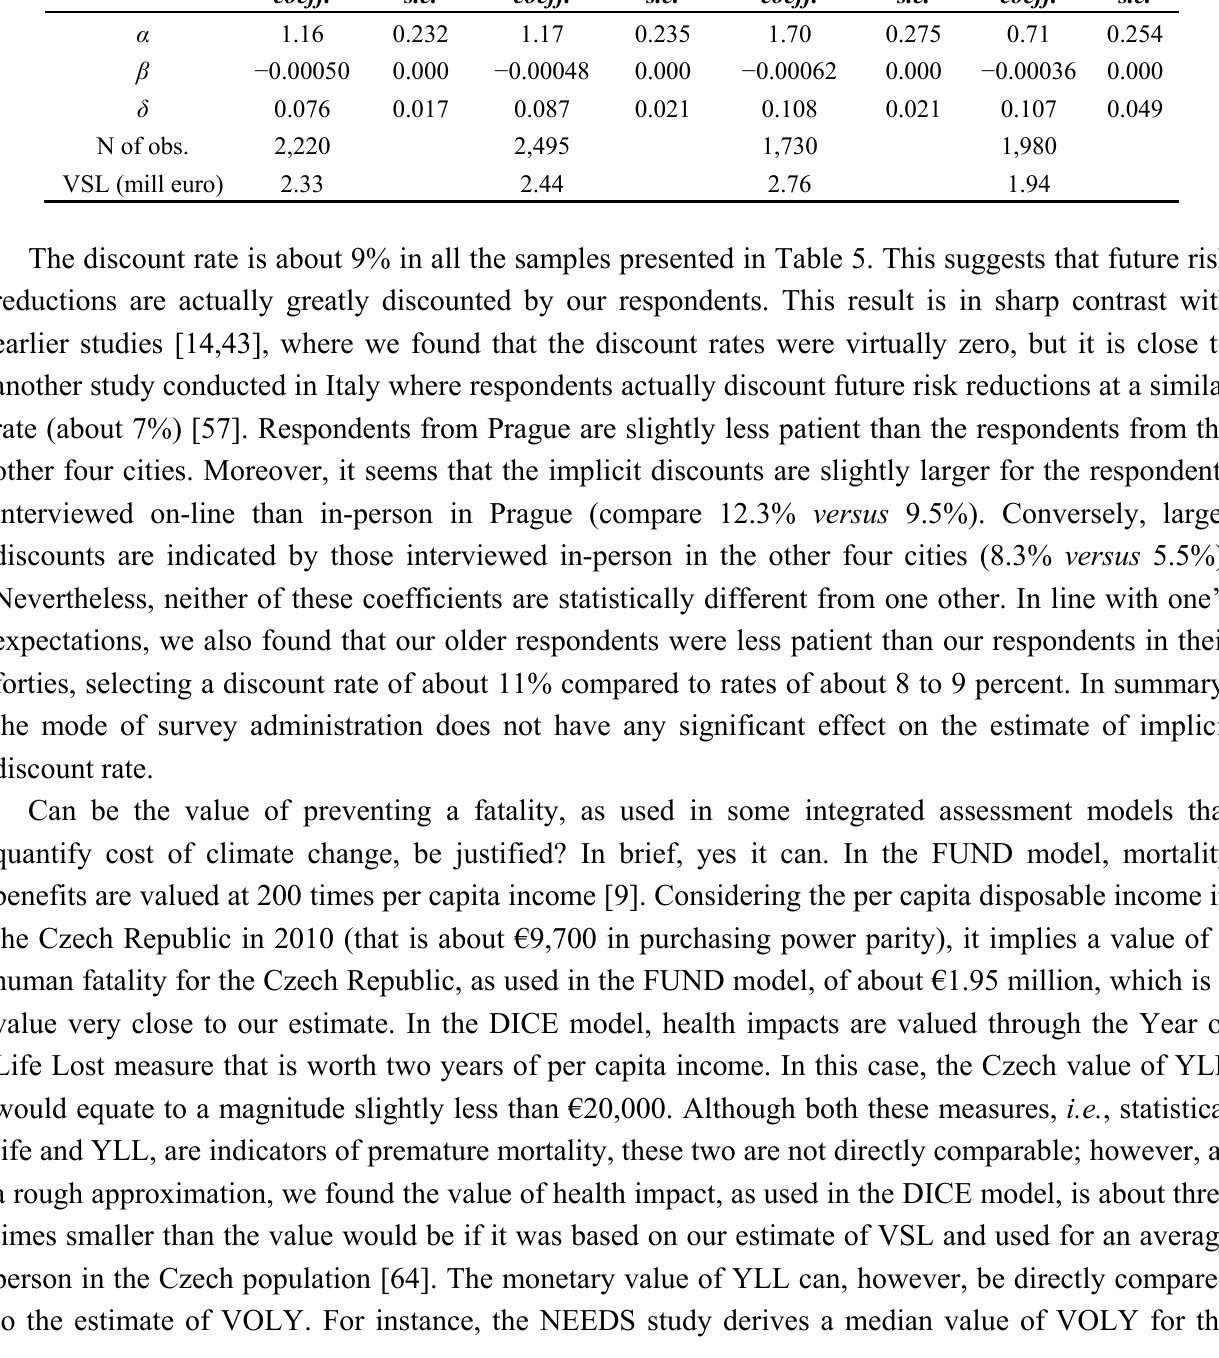
Table 7. VSL estimations for different age of respondents and the mode of survey administration. age 40 − 50 age 51 − 60 CAPI CAWI CAPI